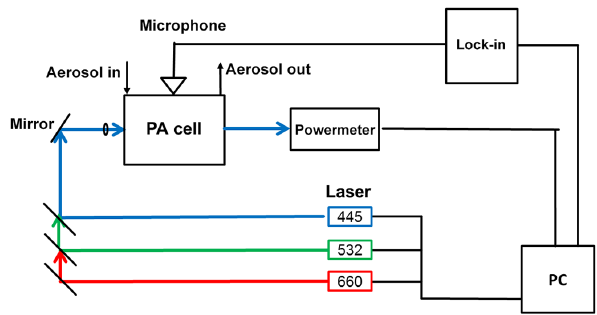
Figure 1. Setup of the three-wavelength photoacoustic spectrome-